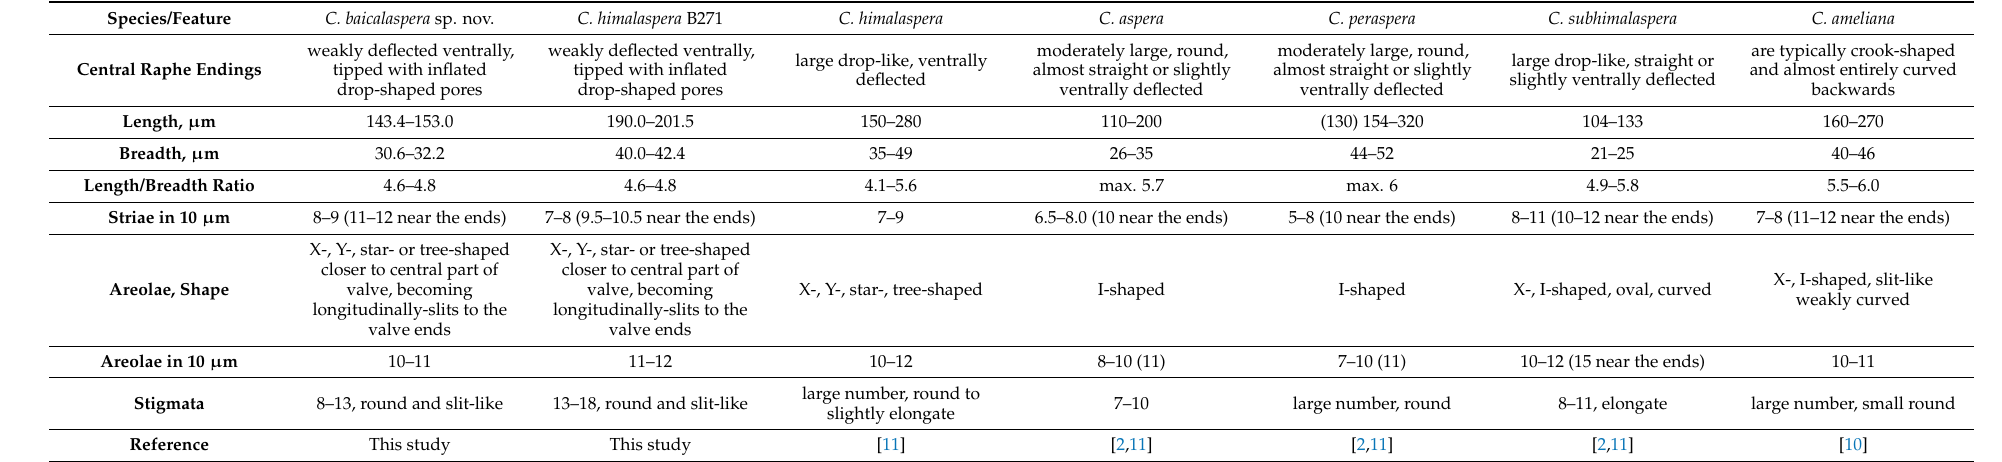
Table 1. Morphological comparison of Cymbella baicalaspera sp. nov., and related